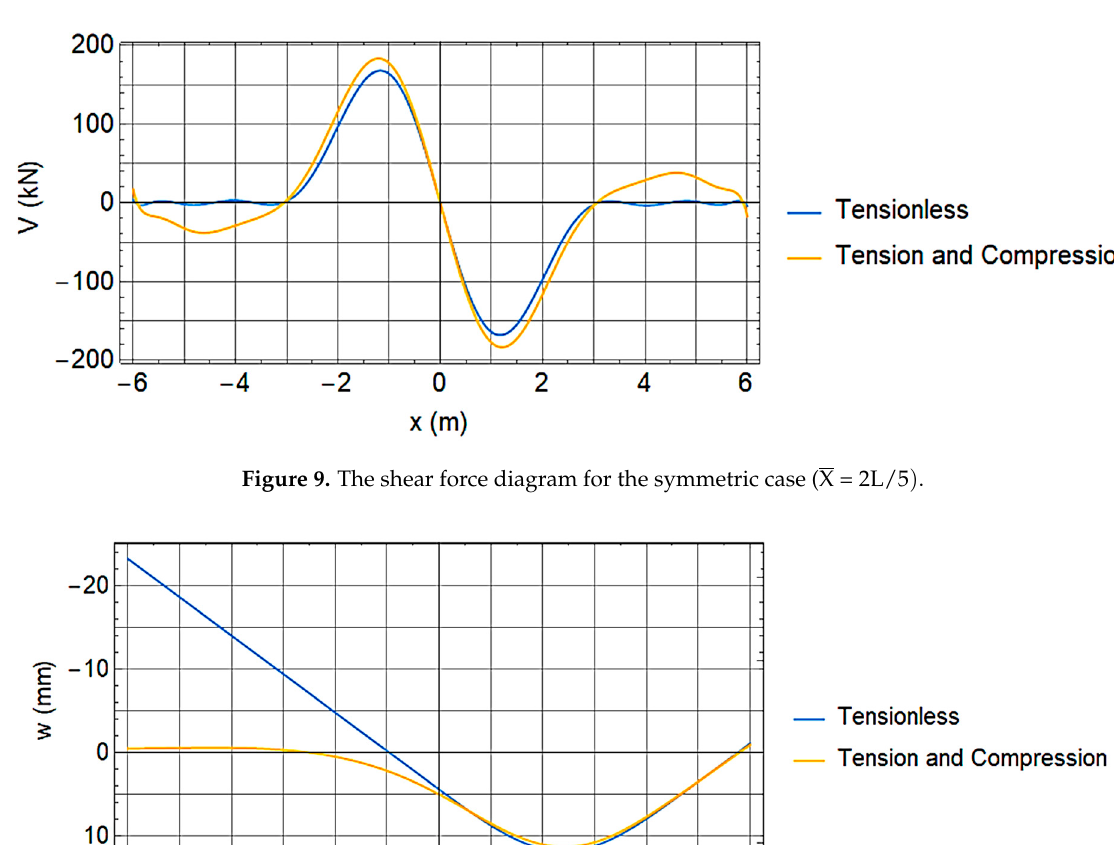
Figure 8. The bending moment diagram for the symmetric case (X = 2L/5 ) .